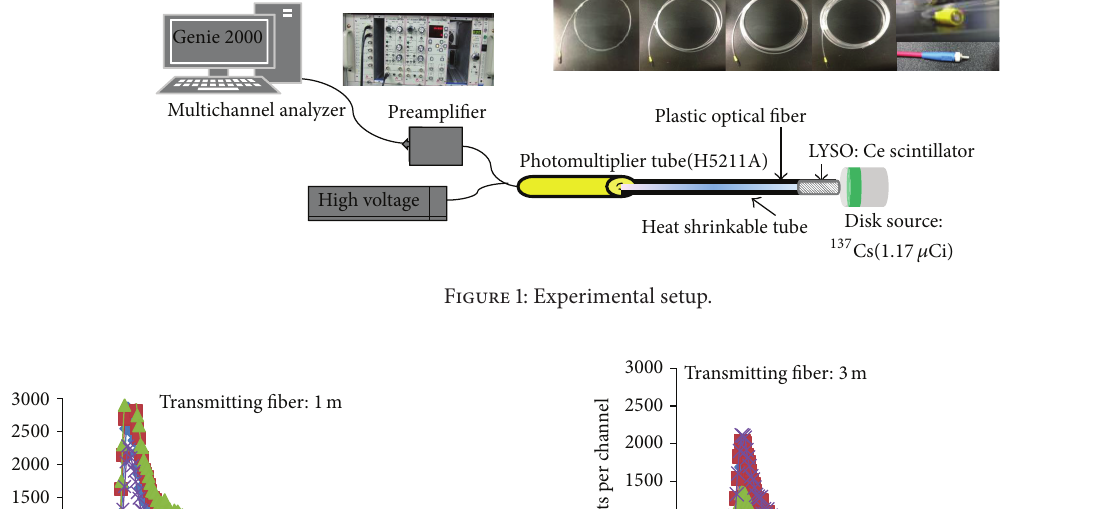
Figure 1: Experimental setup.